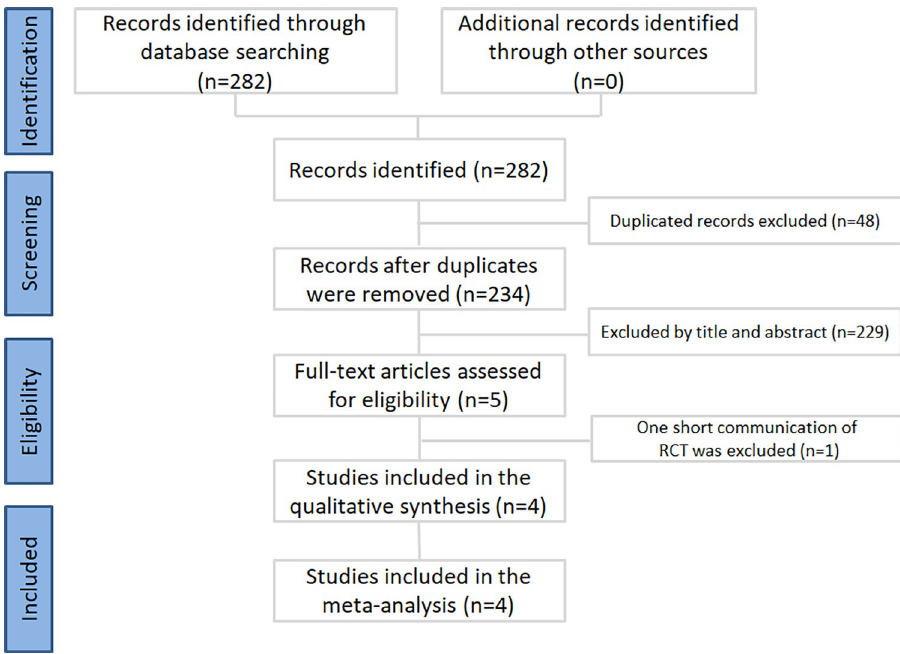
Fig 1. Inclusion process for the identified studies.